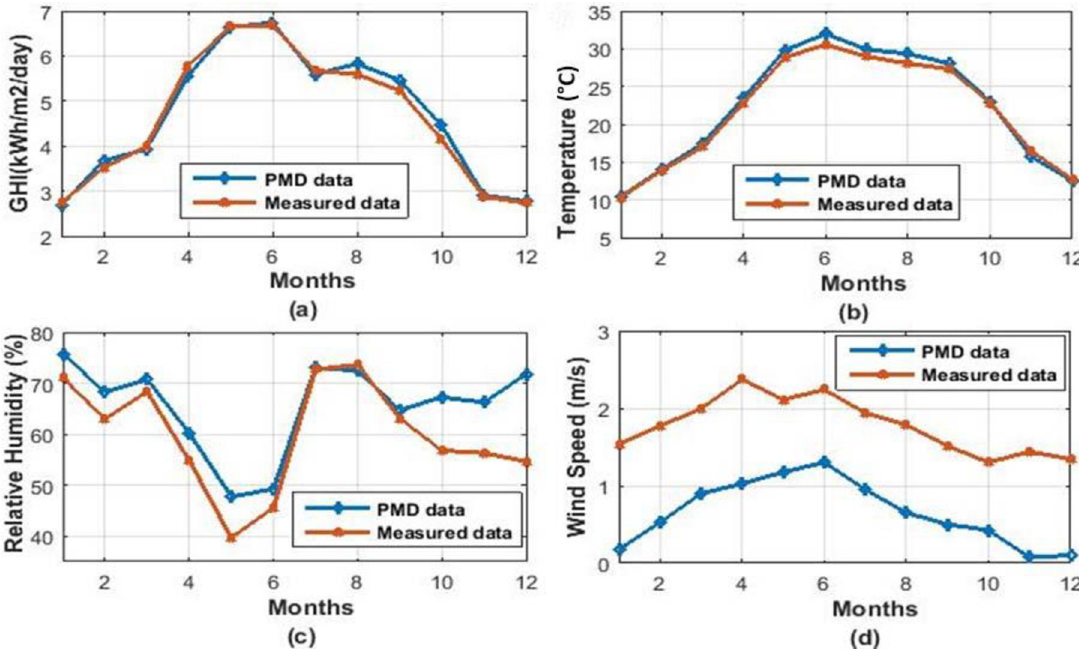
Fig 4. Weather data of Islamabad. (a) Global Horizontal Irradiations (kWh/m 2 /day) (b) Dry bulb Temperature (Celsius) (c) Relative Humidity (%) ( d) Wind Speed (m/s).